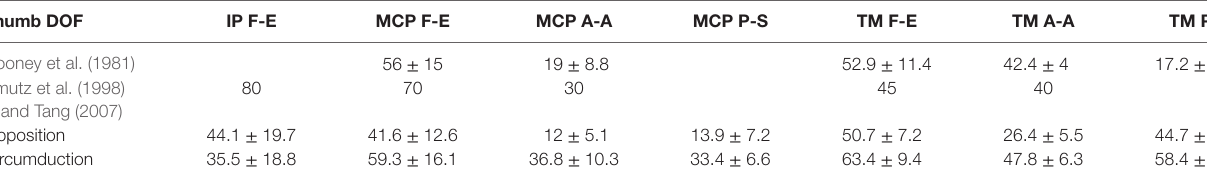
TABLe 1 | Human thumb joint ROMs (in degrees) based on anatomical and experimental studies reported in literature. Thumb DOF iP F-e MCP F-e Cooney et al.